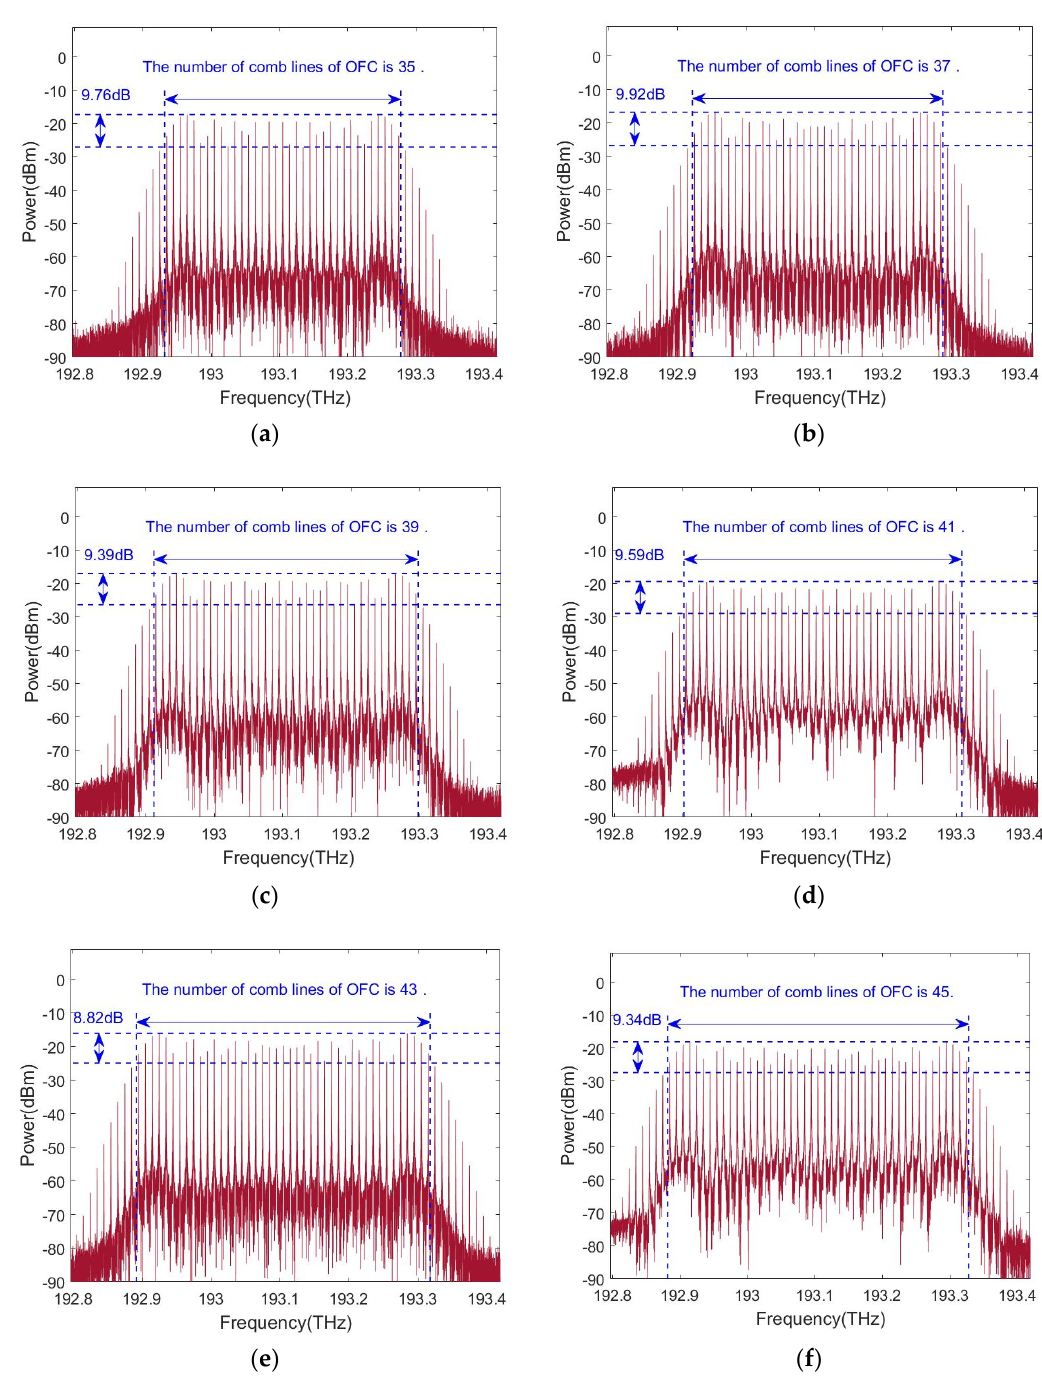
Figure 3. The optical spectra of OFC with different amplitudes of the RF-modulated current: ( a ) 160 mA, ( b ) 170 mA, ( c ) 180 mA, ( d ) 190 mA, ( e ) 200 mA, and ( f ) 210 mA.